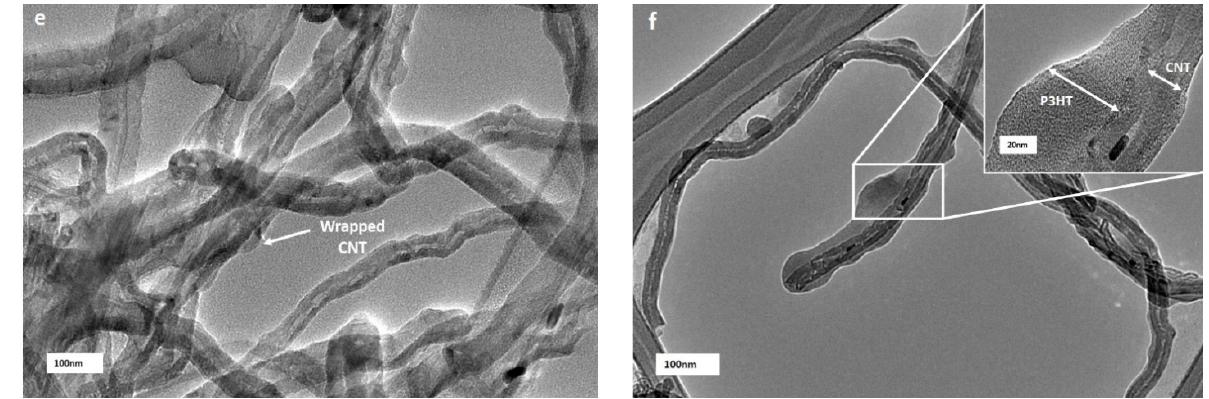
Figure 6. HRTEM image of P3HT/MWCNT-OH nanocomposites at different reaction times ( a ) 24 h, ( b ) 24 h at 10 nm view ( c ) 48 h, ( d ) 72 h, ( e ) 96 h, and ( f ) 120 h.